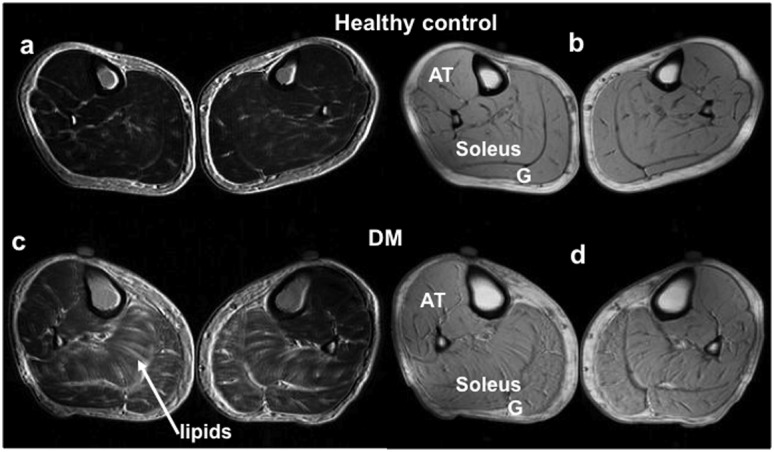
Representative maps of fat (out-of-phase) (a,c) and water (in-phase) (b,d) of healthy controls (a,b) and T2DM subjects (c,d).A dramatic increase of lipid can be seen in the diabetic soleus and gastrocnemius.